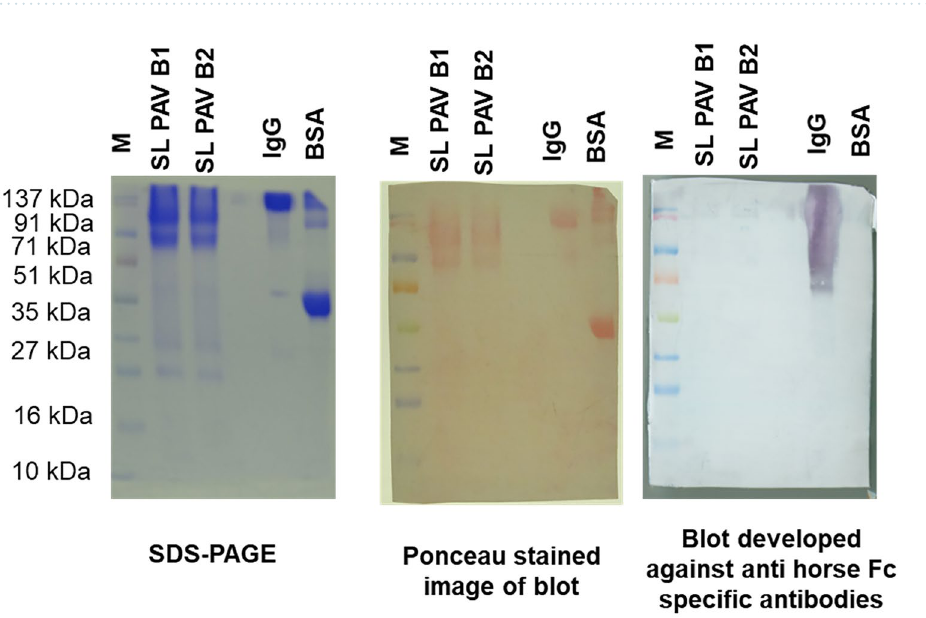
Figure 2. SDS-PAGE analysis of the two batches of SL PAV and their gel filtration fractions under ( a ) non- reduced, and ( b ) reduced conditions. Lanes M, protein molecular markers; lanes 1 and 3 represent PAV of batch B1 and B2, respectively; lanes 2 and 4 represent gel filtration peak GF1 of B1 and B2 of PAV, respectively; lanes 5 and 6 represent purified horse IgG and F(ab ′ ) 2 fragment, respectively. Determination of percent composition of IgG and F(ab ′ ) 2 by densitometry analysis; ( c ) two batches of SL PAV and ( d ) their gel filtration fractions (GF1). ( e ) Analysis of F(ab ′ ) 2 and/or IgG aggregates in the PAVs (B1 and B2) by SDS-PAGE analysis. Values are mean ± SD for triplicate determinations. No significant difference was observed between the two batches of SL PAV (p > 0.05).